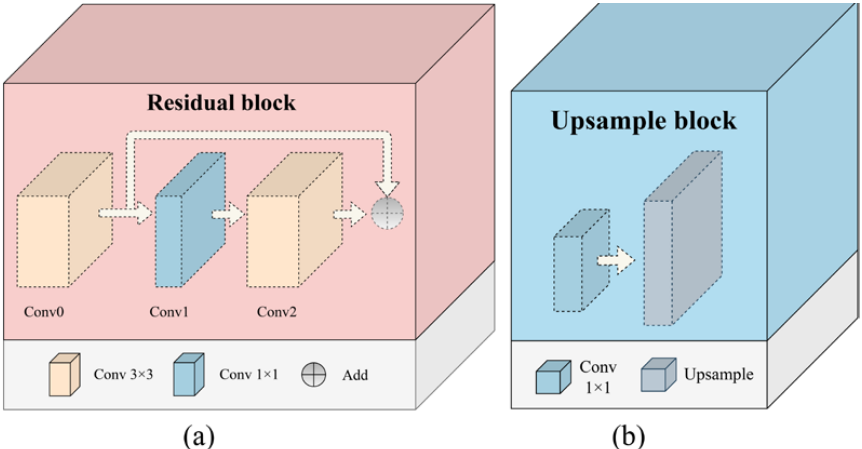
Figure 3. Residual block and Upsample block structure. ( a ) Residual block; ( b ) Upsample block. Table 1. Information of each layer of the two-channel convolutional neural network structure.